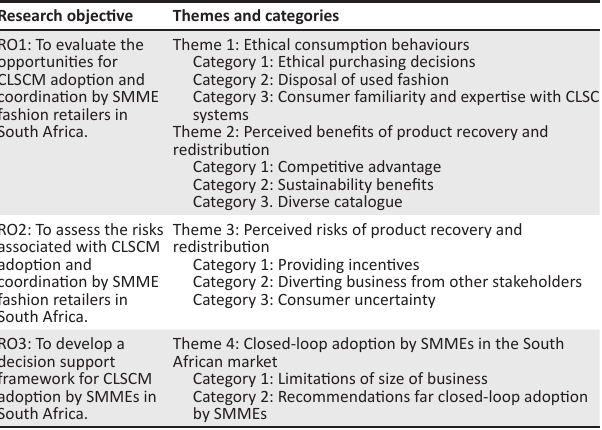
TABLE 2: Link between research objectives, themes and